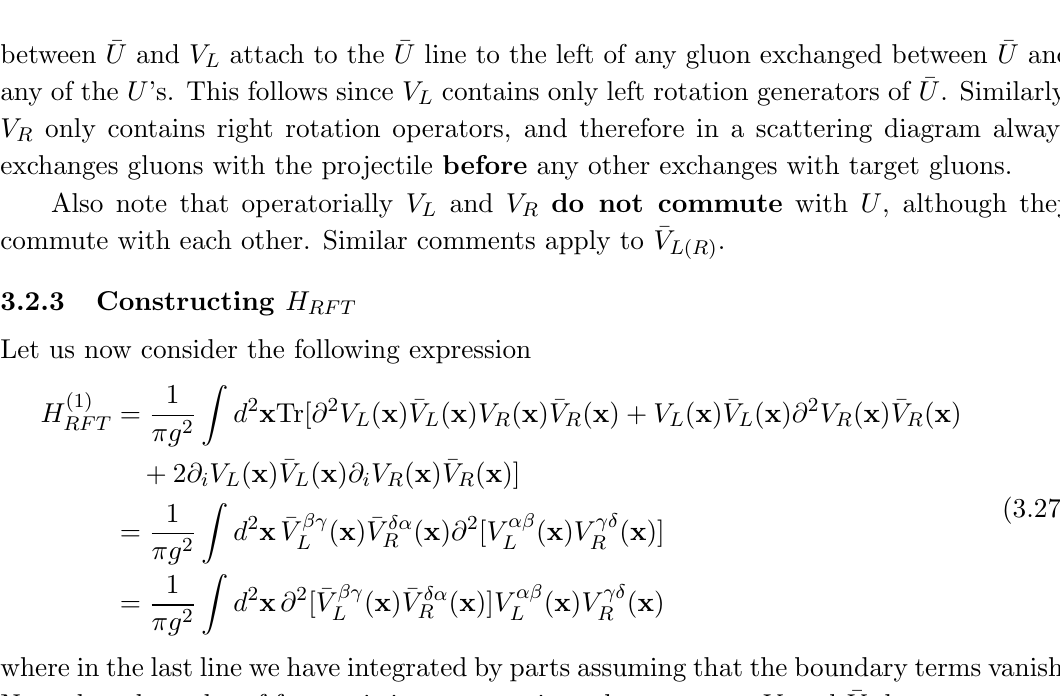
Figure 3. A sample diagram for a correlator that includes V L